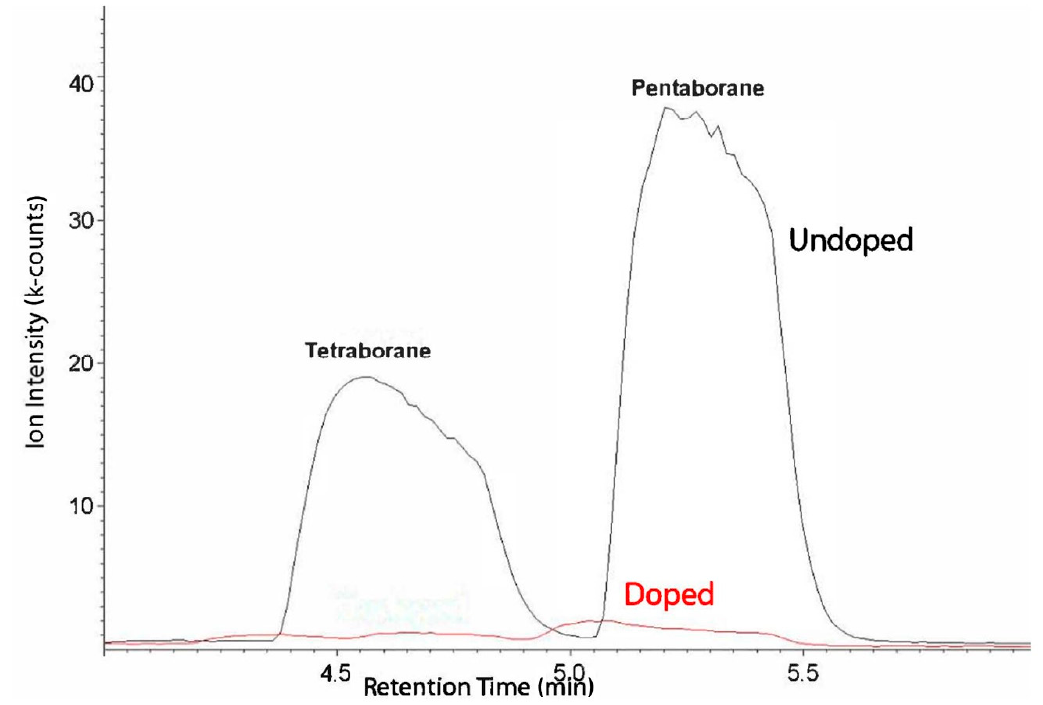
Figure 13. GC–MS profiles (B x H y ion counts vs. retention time) of undoped and nano-Ni doped Zn(BH 4 ) 2 .